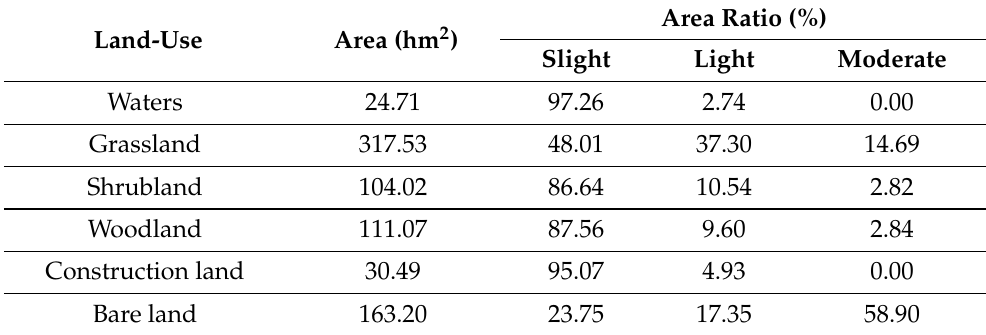
Table 4. Soil erosion intensity of different land use types.